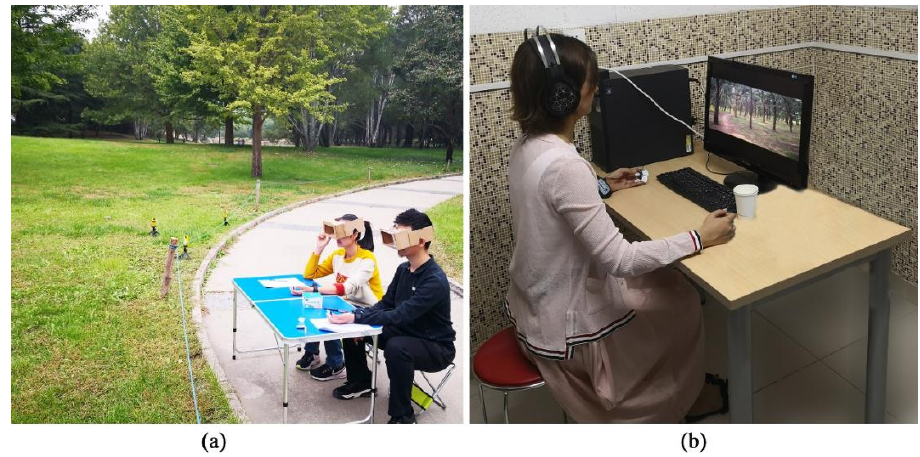
Figure 2. The hierarchical arrangement of participation groups.